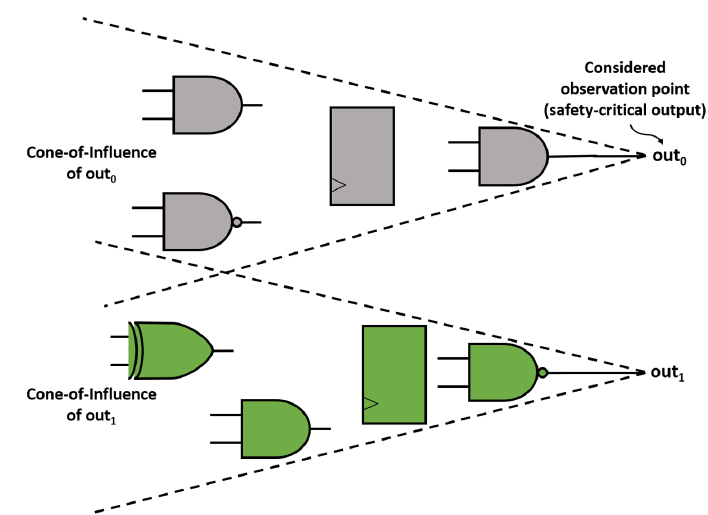
Figure 2. Out-of-COI example when out 0 is the only safety critical output.